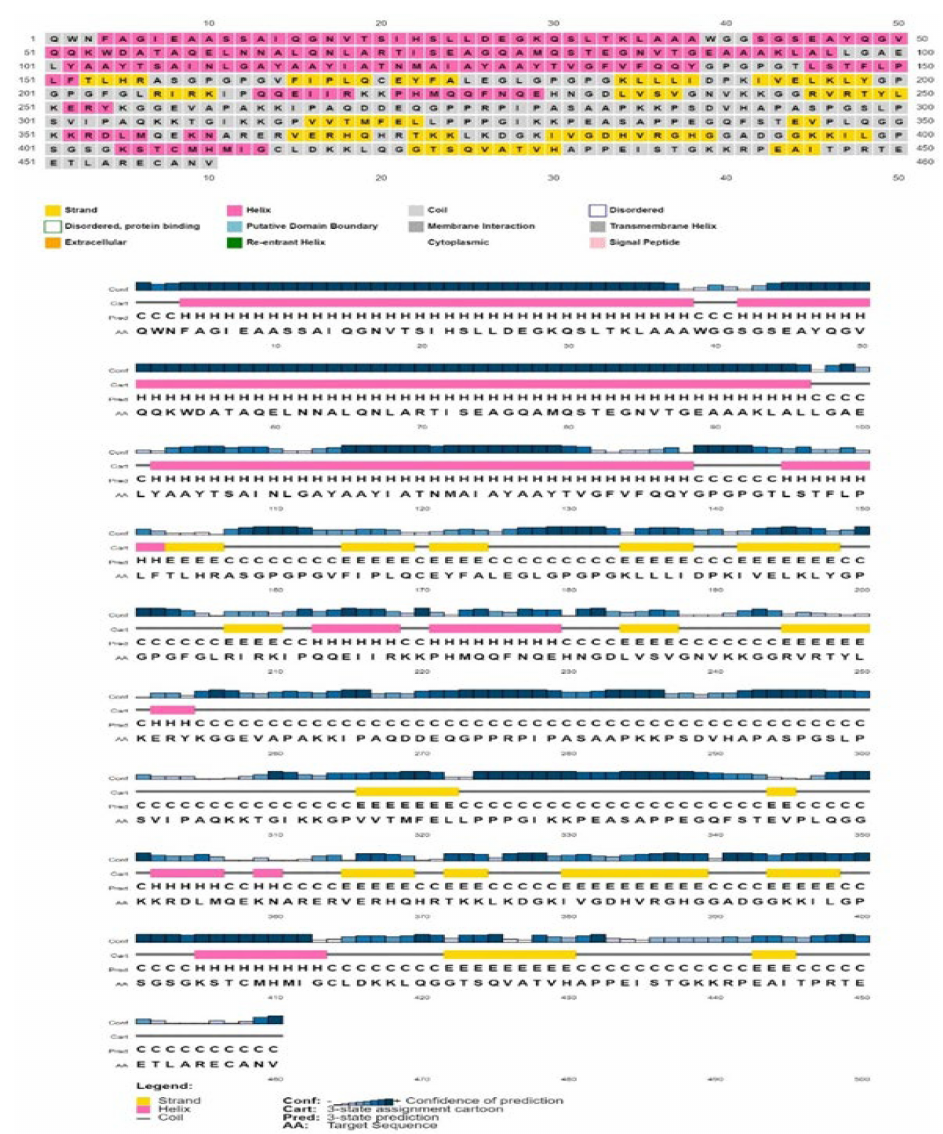
Figure 5. Secondary structural features of the constructed vaccine. Herein, α -helix (36.74%), β -strands (45.22%), and random coils (18.04%) are represented with pink, yellow, and blue colors,